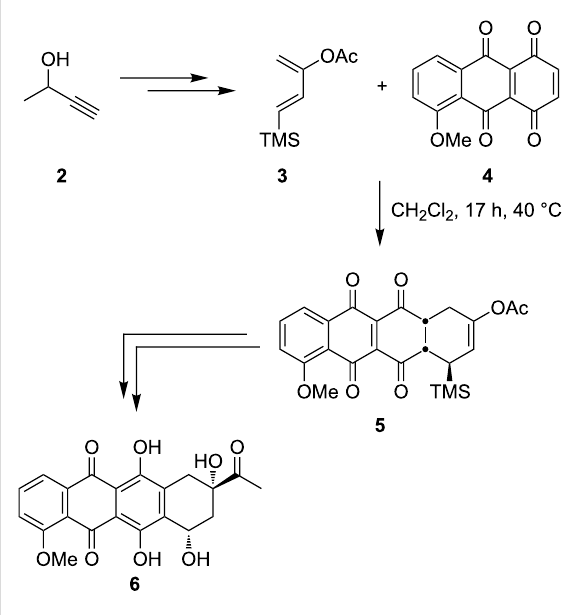
Scheme 1: Total synthesis of daunomycinone 6 according to